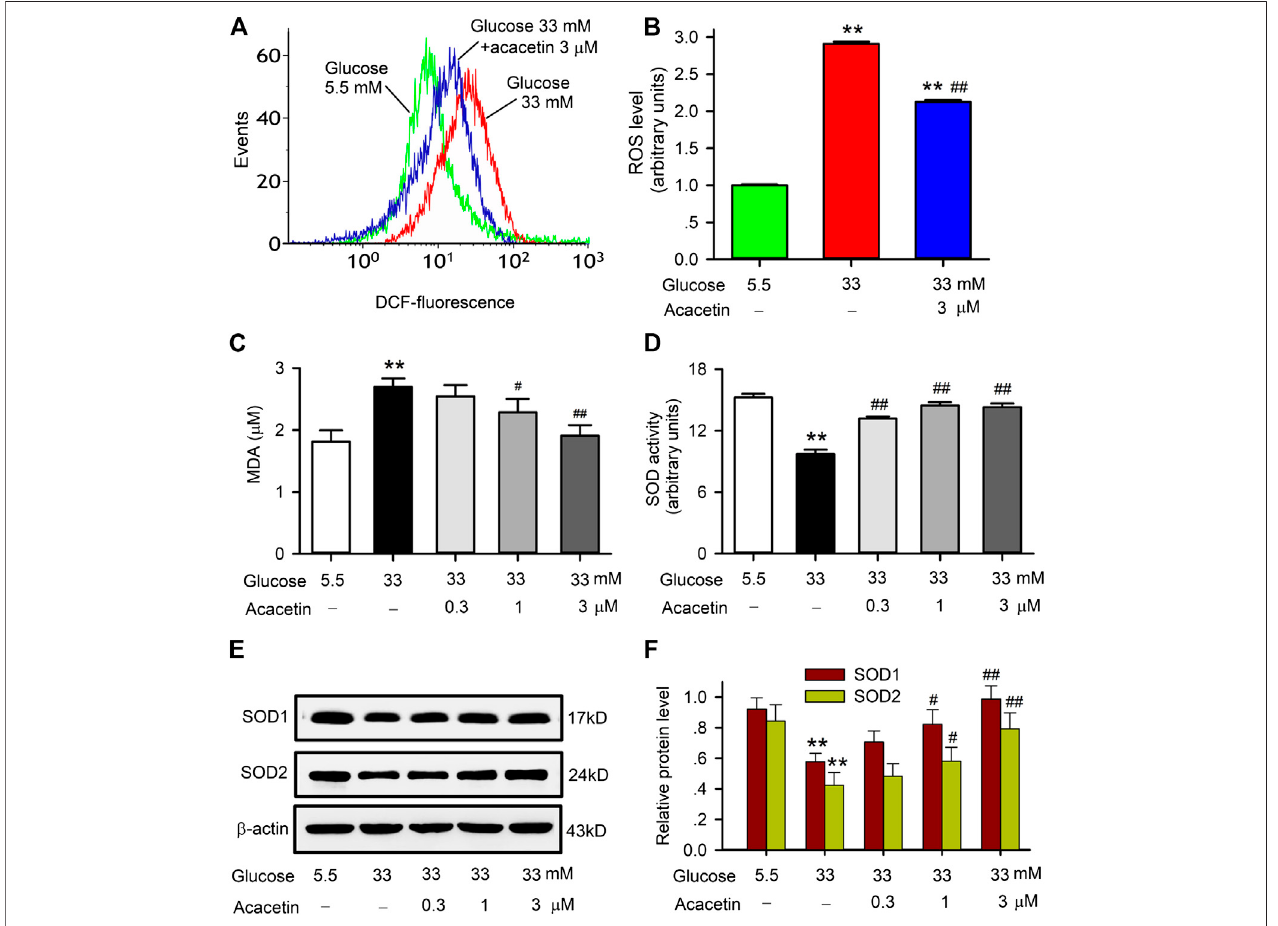
FIGURE 2 | Effects of acacetin on ROS production and alteration of superoxide dismutase in HUVECs induced by high glucose exposure. (A) Flow cytometry graphs of ROS production in HUVECs cultured with 5.5 mM glucose medium, 33 mM glucose medium or 33 mM glucose medium plus 3 μ M acacetin. (B) Acacetin decreased high glucose-induced ROS increase. (C) Acacetin decreased high glucose-induced MDA increase in a concentration-dependent manner. (D) Acacetin reversed high glucose-induced decrease in SOD activity in a concentration-dependent manner. (E) Western blots of SOD1 and SOD2 in HUVECs cultured with 5.5 mMglucosemedium,33 mMglucose medium or33 mMglucosemedium plusacacetin. (F) Acacetinreversedhighglucose-induced reduction ofSOD1and SOD2 proteins in a concentration-dependent manner. n (cid:2) 5 individual experiments, ** p < 0.01 vs. 5.5 mM glucose; # p < 0.05, ## p < 0.01 vs. 33 mM glucose).